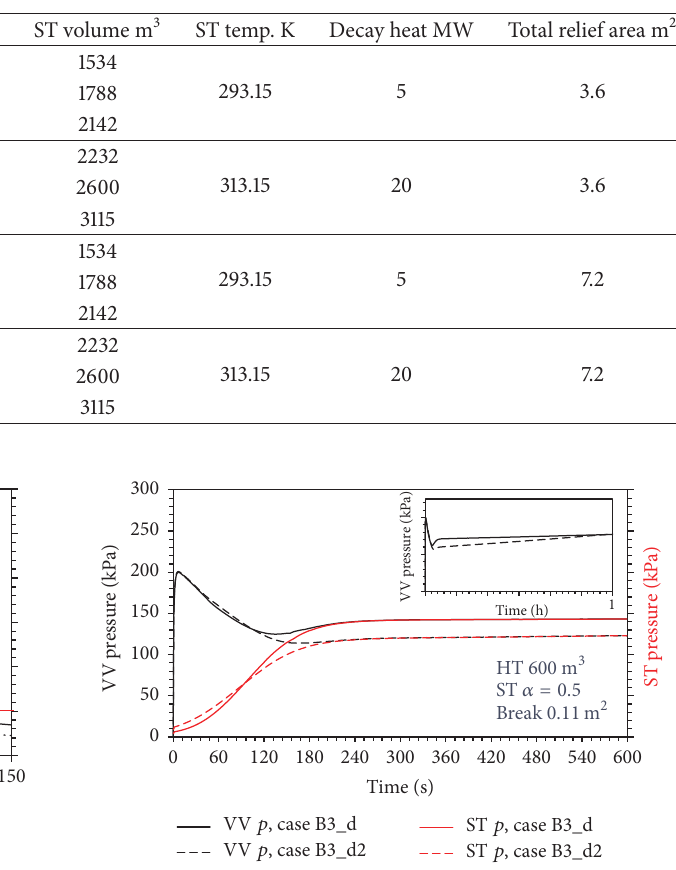
Table 4: Sensitivity analyses with the estimated ST volume and relief area.